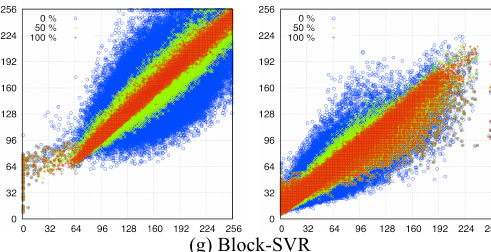
(g) Block-SVR Figure 5. Scatterplots of the original (horizontal) and pansharpened (vertical) NIR band in agricultural (left) and urban (right) areas The respective values of GLP-SDM and GIHSA were 1.00 and over 0.99 in both areas.